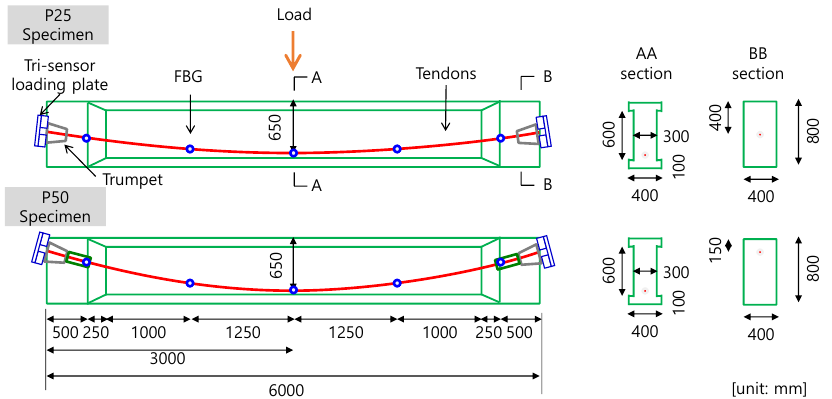
Figure 9. Details about the post-tensioned girder specimens and sensors installed. P25, eccentricity of tendon profile set to be 250 mm; P50, eccentricity of tendon profile set to be 500 mm. Tri-sensor loading plates were installed at both (live and dead) ends of the beam in order to measure the pre-stressing forces. The live anchor refers to the end where the pre-stressing is applied, and the dead anchor means the opposite end where pre-stress is not applied. Because the